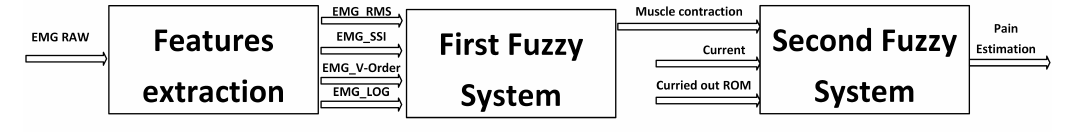
Figure 2. The fuzzy system architecture.